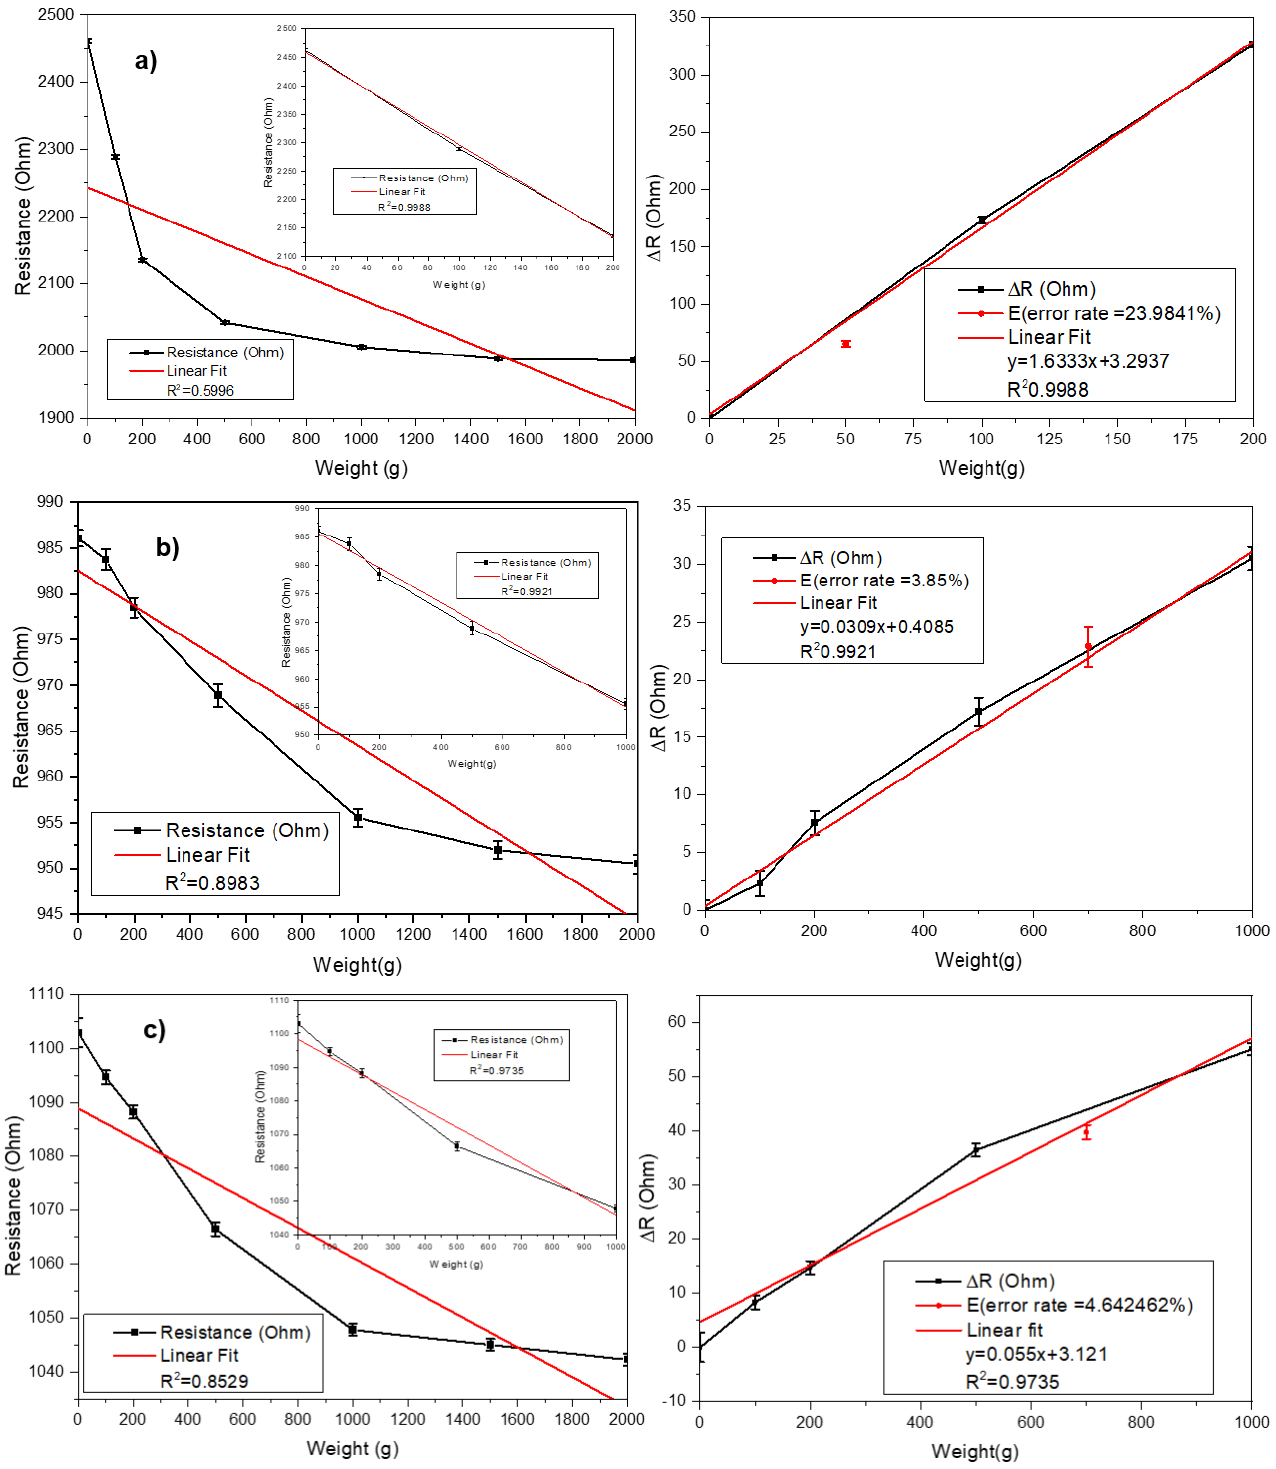
Figure 8. The compression test results for ( a ) single − layer, ( b ) double − layer, and ( c ) quadruple − layer sensors.